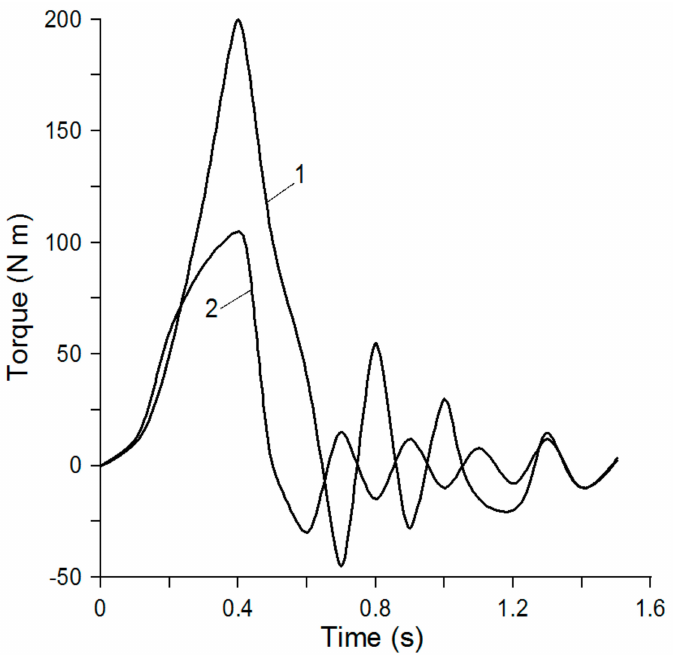
Figure 7. Dynamics torque M pto at the various operating modes of the tractor’s front PTO: 1–540 rpm; 2–1000